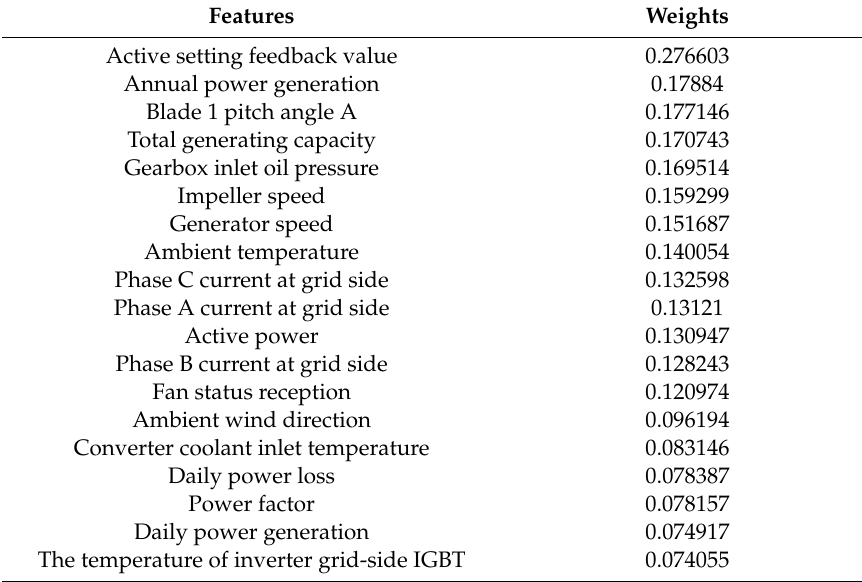
Table 3. Observed feature